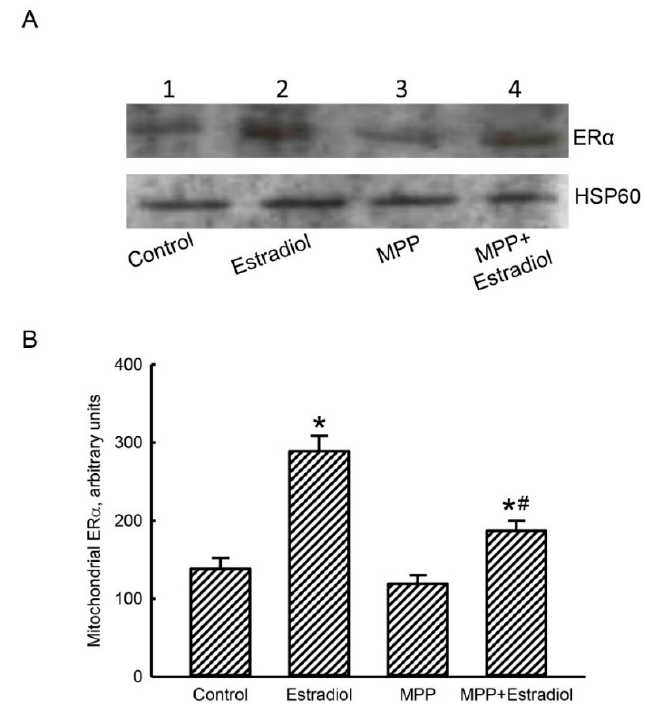
Figure 2. Methylpiperidinopyrazole (MPP) decreased estradiol-induced translocation of estrogen receptor- α (ER α ) to mitochondria from the cytoplasm in rat calvarial osteoblasts. Primary osteoblasts isolatedfromneonatalratcalvariaswereexposedto10nMestradiol,100 µ MMPP,andacombinationofMPP andestradiolfor24h. Aftertreatment, mitochondrialproteinswereprepared, andtheirconcentrationswere measured. These mitochondrial proteins were loaded onto sodium dodecylsulfate (SDS)-polyacrylamide gel electrophoresis (PAGE) followed by electronic separation. After being electronically transferred onto membranes, levels of mitochondrial ER α were immunodetected ( A , top panel). Amounts of heat shock protein 60 (HSP60) in membranes were measured as the internal control for mitochondrial protein loading (bottom panel). These immune-related protein bands were quantified using HSP60 as a loading control, and these data were statistically analyzed ( B ). Each value represents the mean ± standard deviation of at least three independent determinations. The symbols * and # indicate that values significantly ( p < 0.05) differed from the control and estradiol-treated groups,